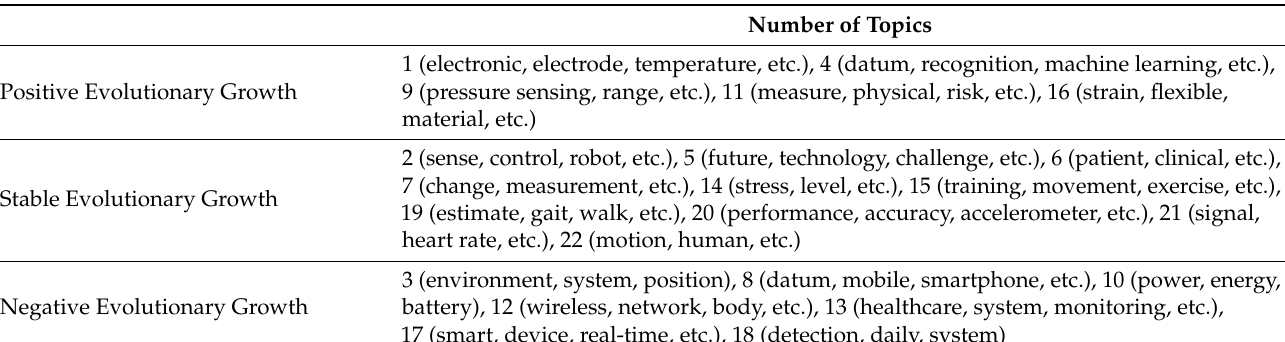
Table 5. Dynamics of trends in wearable sensors using trend analysis.